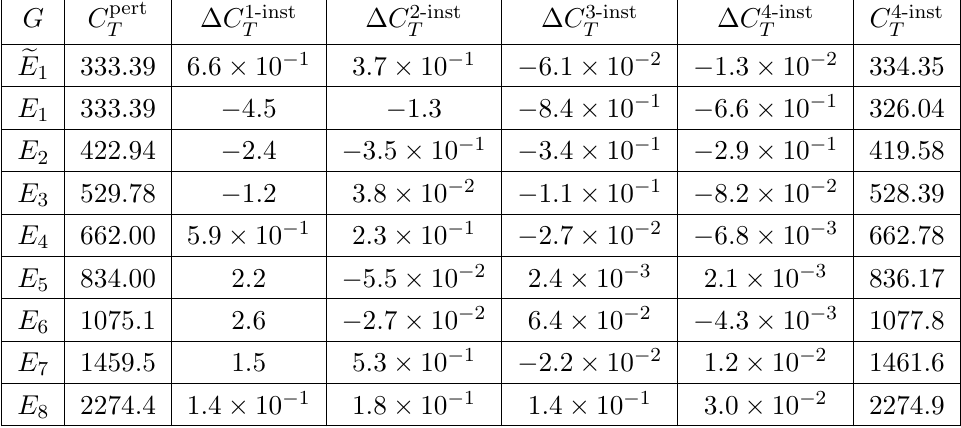
Table 3. The contributions to the values of the conformal central charge C T at each instanton number in the rank-one Seiberg exceptional theories and the Morrison-Seiberg e E 1